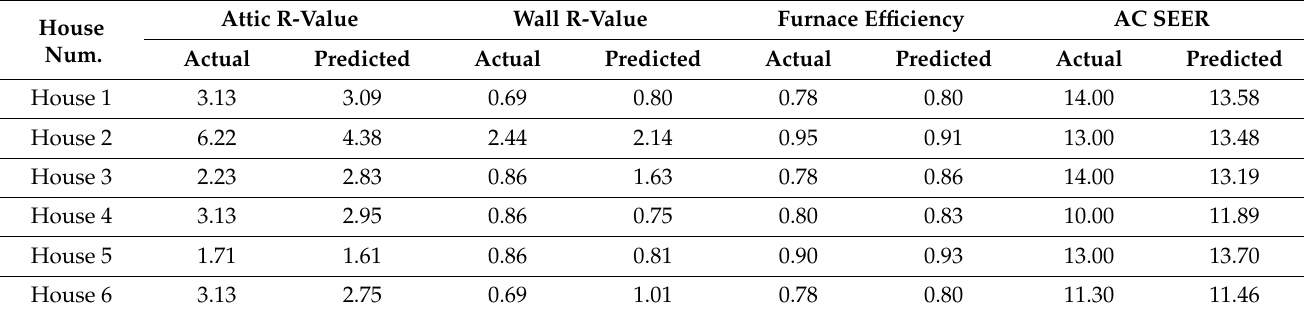
Table 13. Actual and predicted data for the testing houses without using thermostat-derived information. House Num.